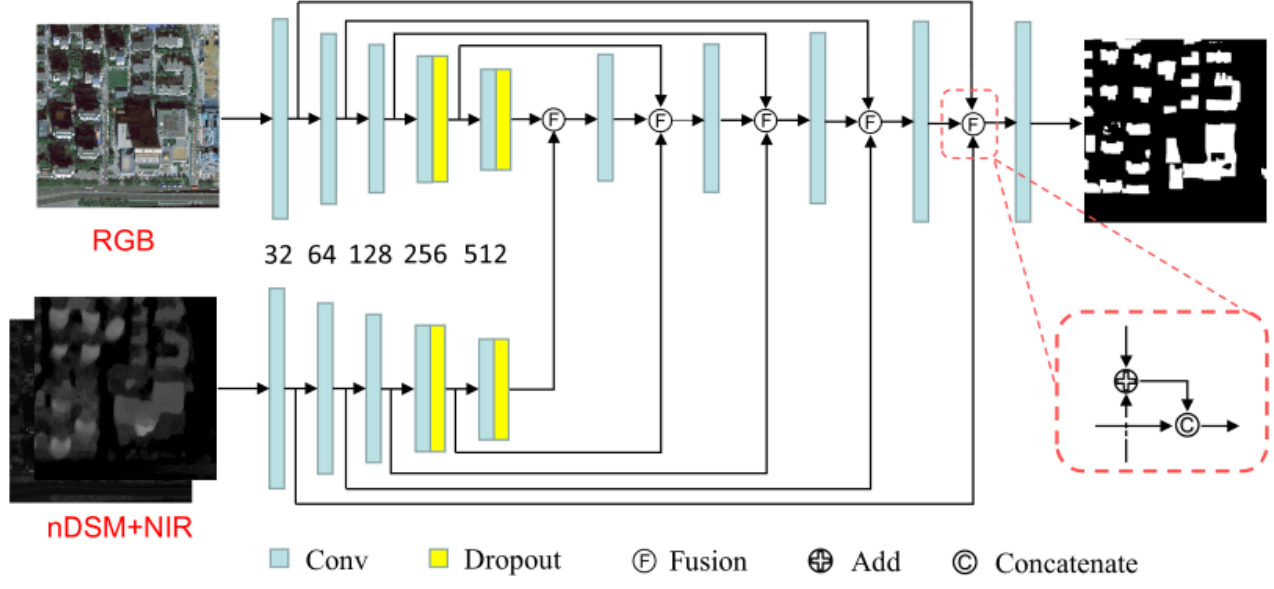
Figure 4. Dual-stream fusion structure.